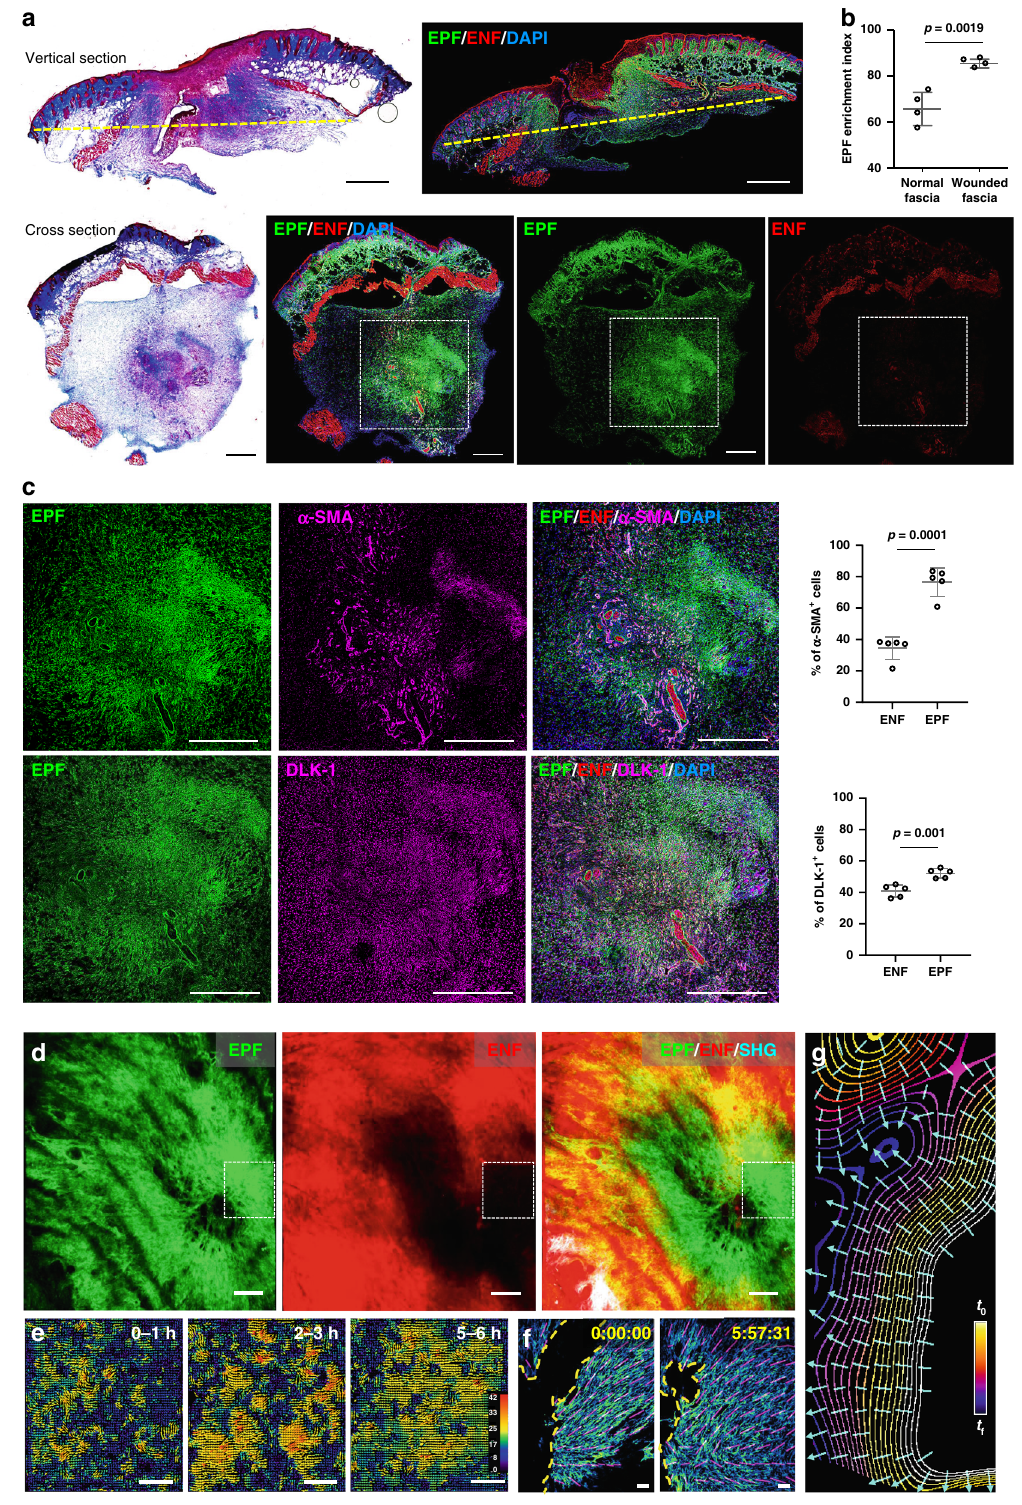
mentary Fig. 4h, i), and expressed myo fi broblast markers α -SMA and DLK-1 (Supplementary Fig. 4j, k), exactly as in animals (Fig. 1a, b, d). α -SMA expression in EPFs was initially low (3.6 ± 2.7%) but substantially increased in SCADs on day 5 (41.3 ± 13.3%) mirroring the upregulation of α -SMA on myo fi